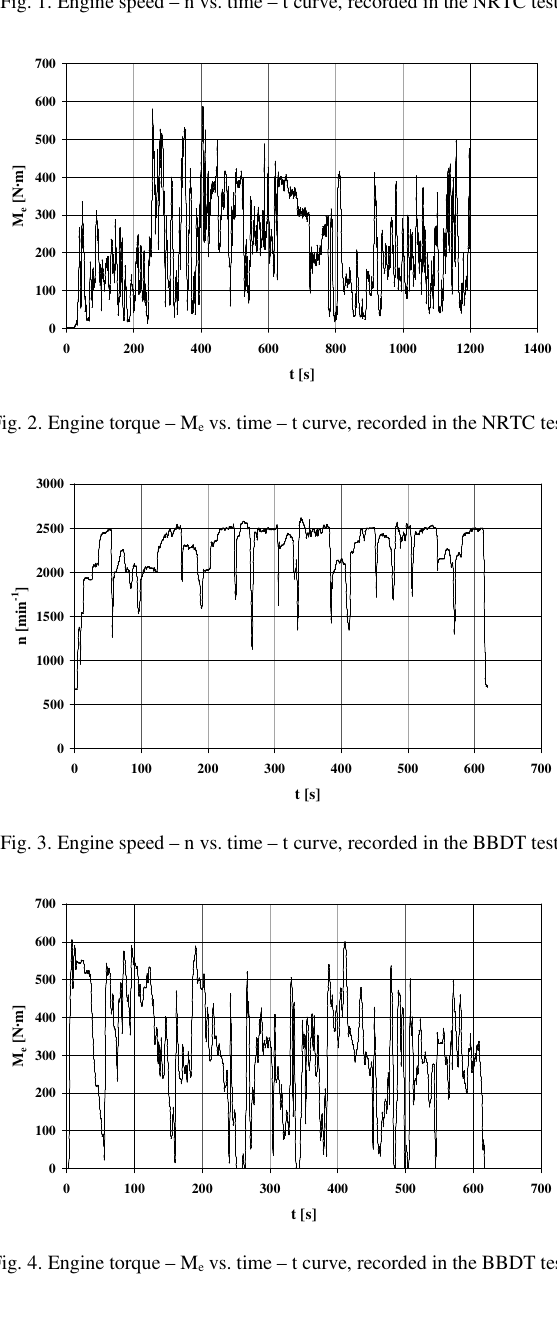
Fig. 1. Engine speed – n vs. time – t curve, recorded in the NRTC test